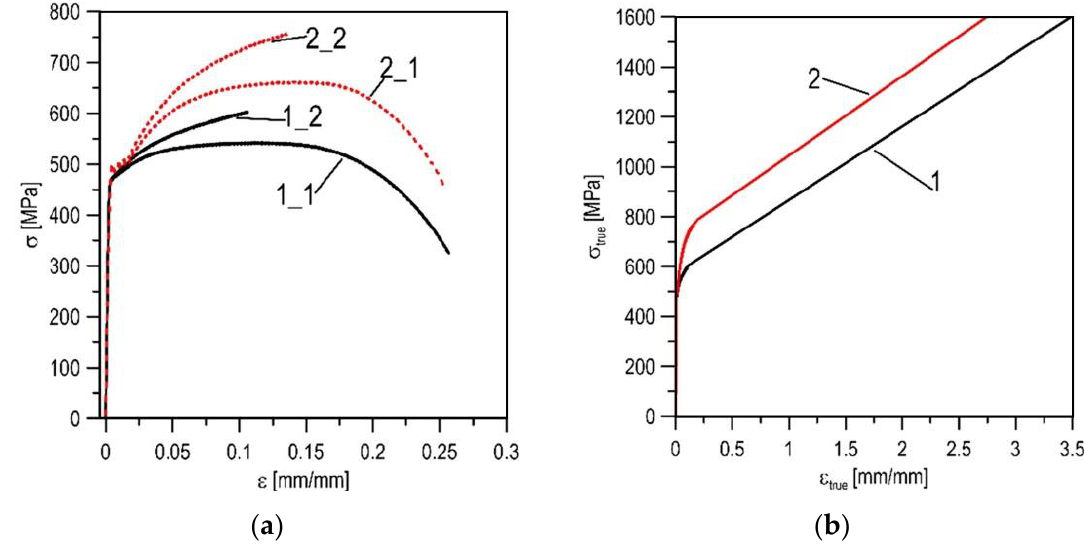
Figure 6. The stress – strain graphs of the X52 steel in as-received state (1) and after 30 years of service (2): ( a ) — the nominal curves (1_1, 2_1) and true curves for section of uniform tension (1_2, 2_2); ( b ) — the full true stress – strain dependences.